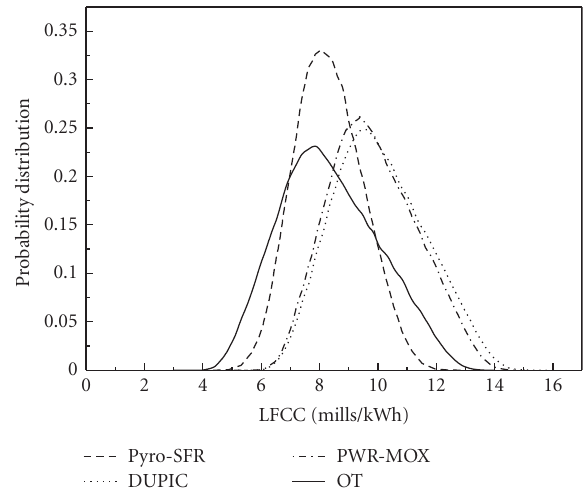
Figure 5: Comparison of the probabilistic density function of LFCCs using a triangular